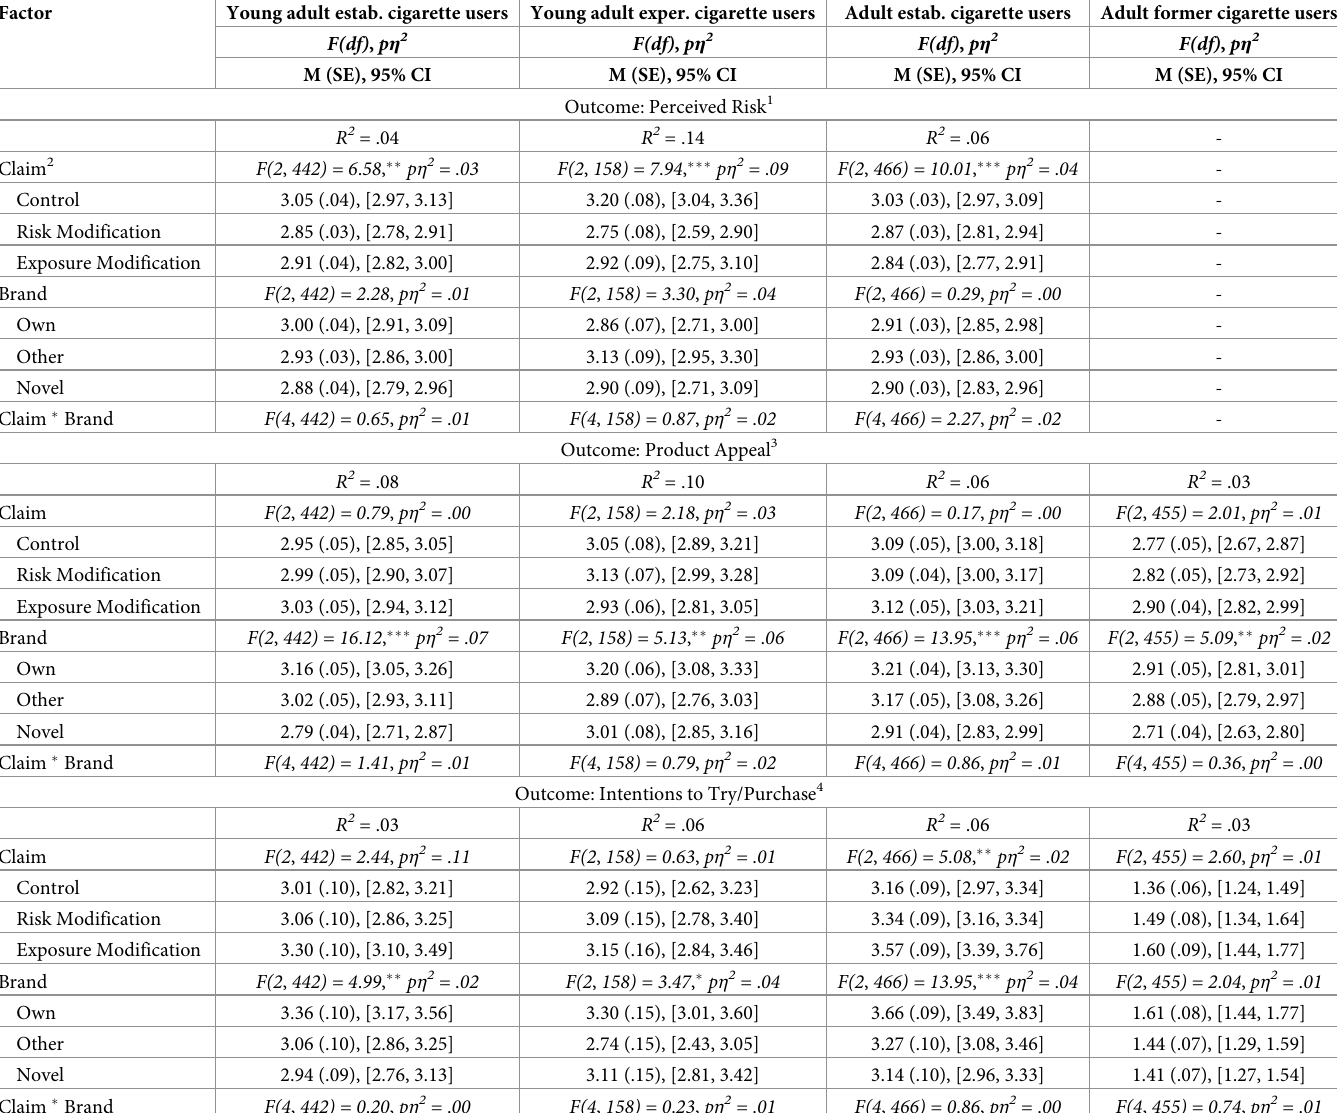
Table 3. Effects of claim and brand condition on perceived risk, product appeal, and intentions to